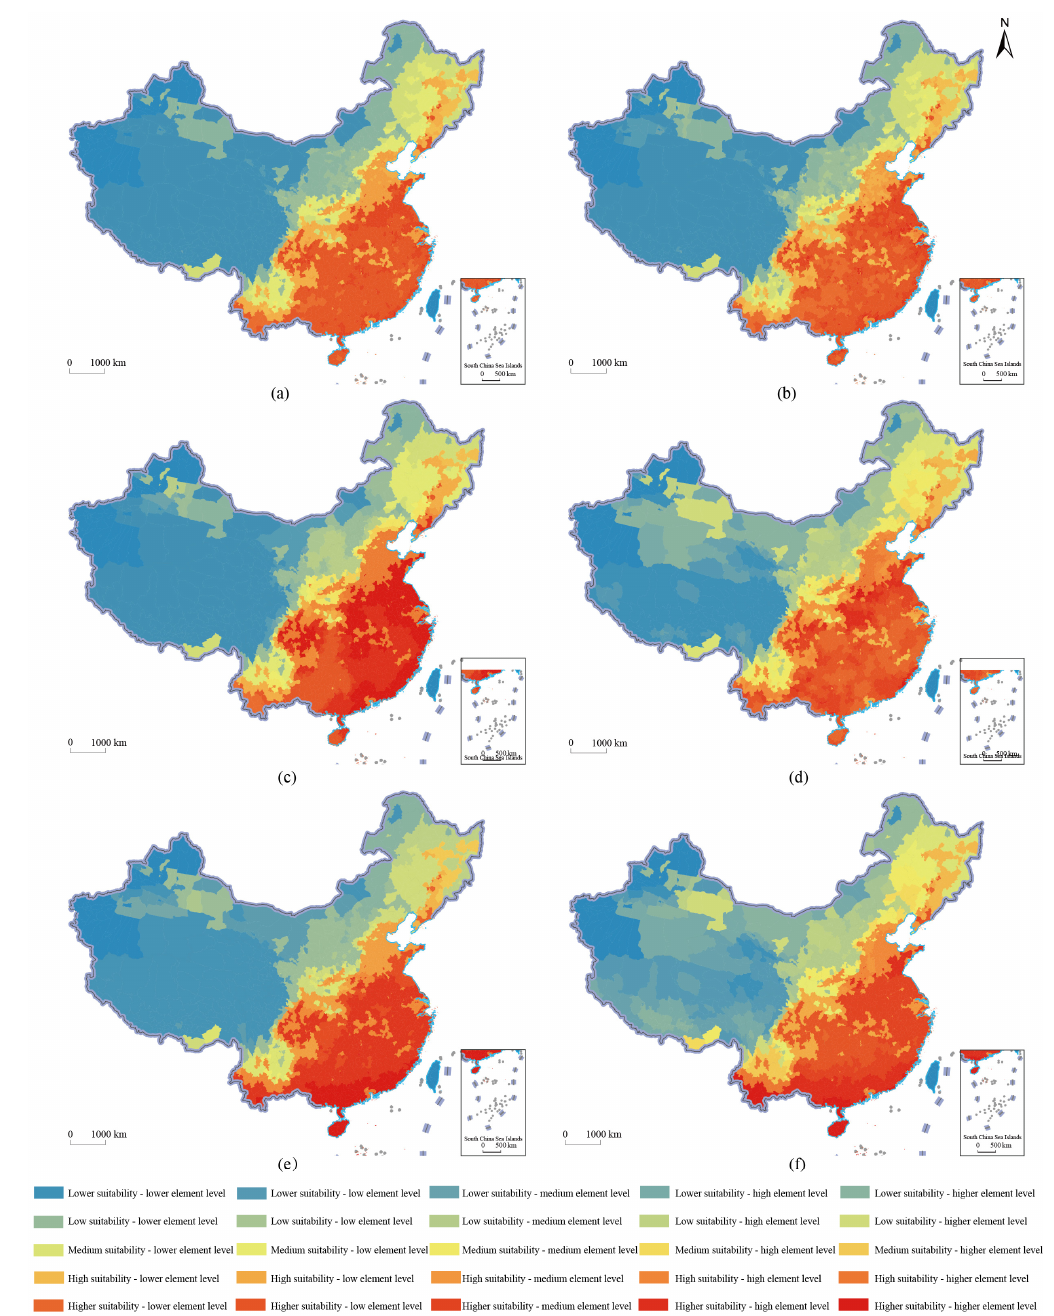
Figure 4. Distribution of agricultural production space suitability and spatial matching of factors in China in 2018. ( a ) population density; ( b ) night light index; ( c ) land-average secondary industry added value; ( d ) water-heat imbalance index; ( e ) average annual temperature; ( f ) crop water demand.